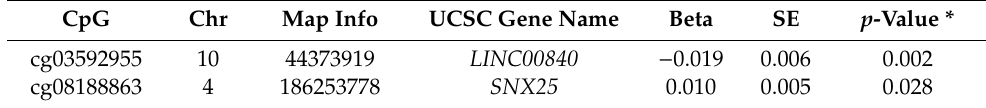
Table 4. Exclusive breastfeeding duration > 3 months vs. DNAm at cg03592955 and cg08188863 at 10